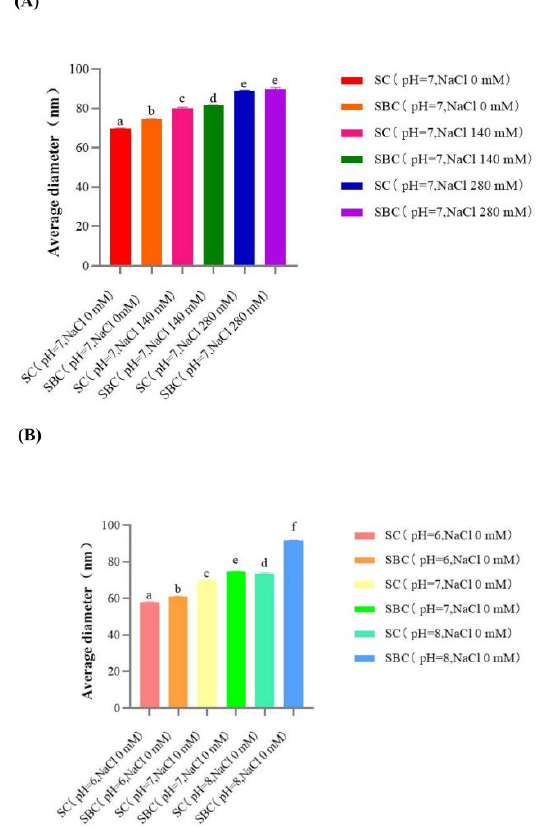
Figure 9. Morphological observation of C. idella swim bladder collagen (SBC) fibrils under different salinity and pH: ( A – C ) collagen with NaCl concentration of 0, 140, and 280 mM and pH 6; ( D – F ) collagen with NaCl concentration of 0, 140, and 280 mM and pH 7; ( G – I ) collagen with NaCl concentration of 0, 140, and 280 mM and pH 8. Scale bars, 2 μm.